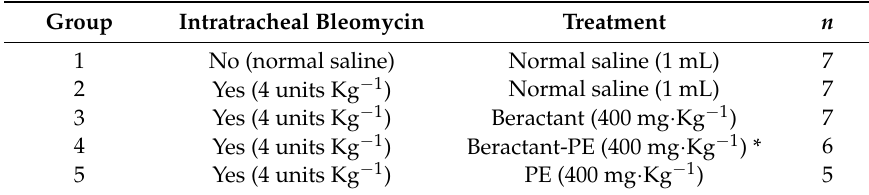
Table 1. Treatment protocol of C57/BL Table 1 . Treatment protocol of C57/BL mice.